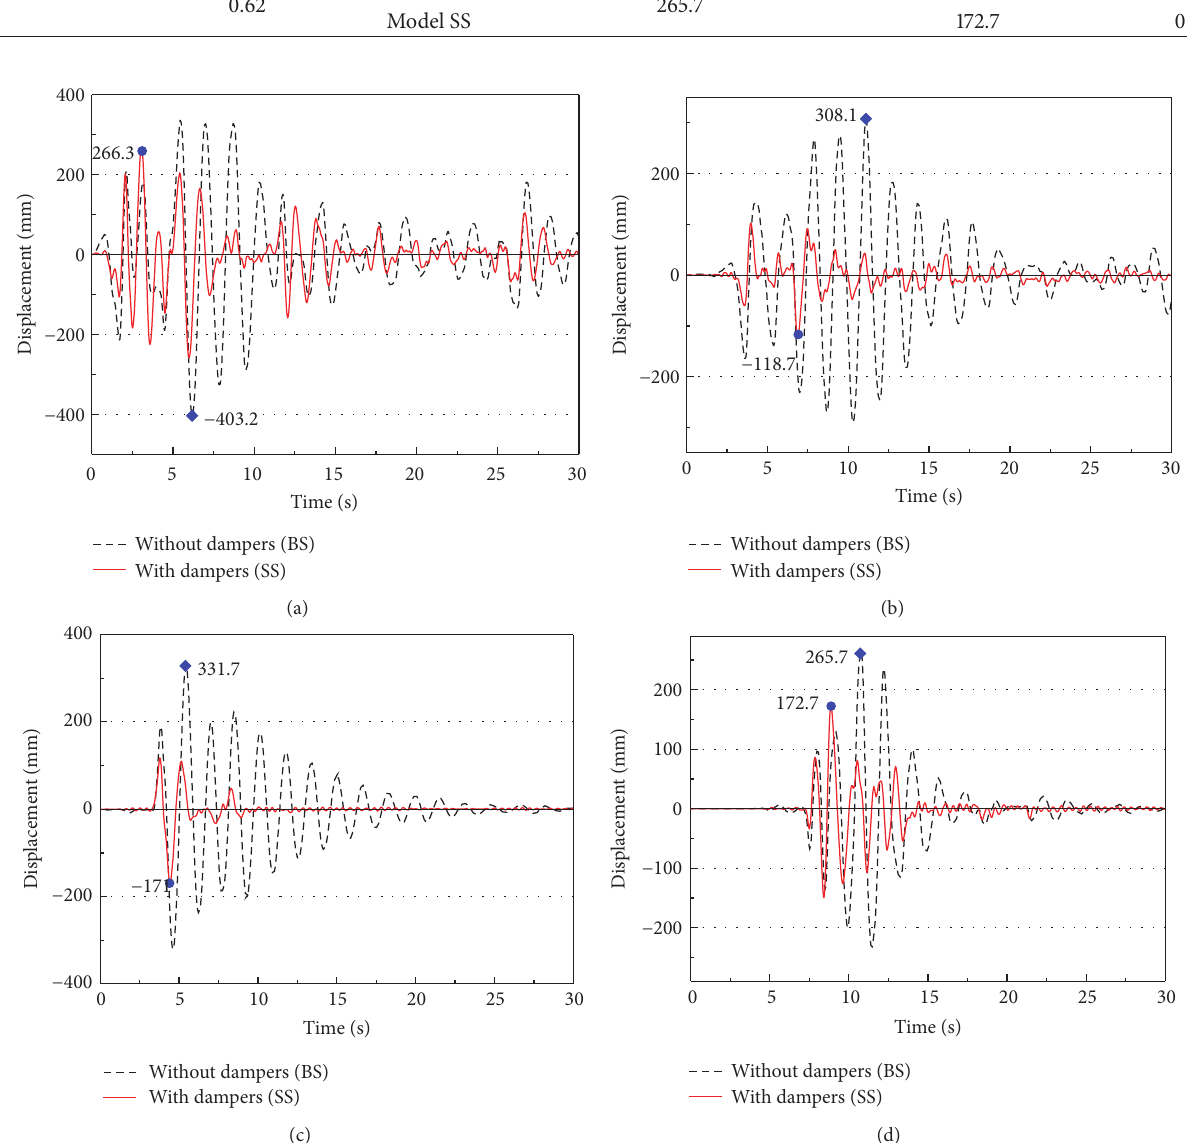
Figure 15: Time-history response of displacement at the top of the portal leg of Models BS and SS for PGA = 0.62 g: (a) El Centro, (b) Taft EW, (c) Northridge EW, and (d) Kobe